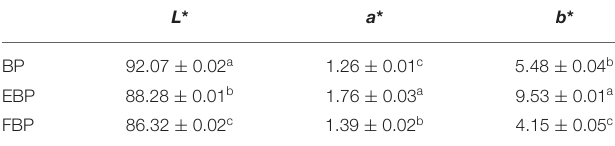
TABLE 4 | Color of BP, EBP, and FBP.